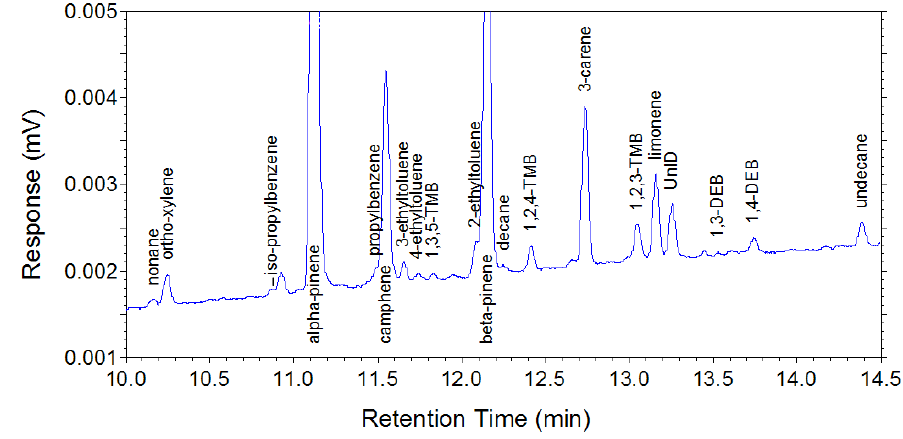
Fig. 3. Portion of a chromatogram recorded at THF on 3 August, 04:23 LT during a period of elevated monoterpene mixing ratios.